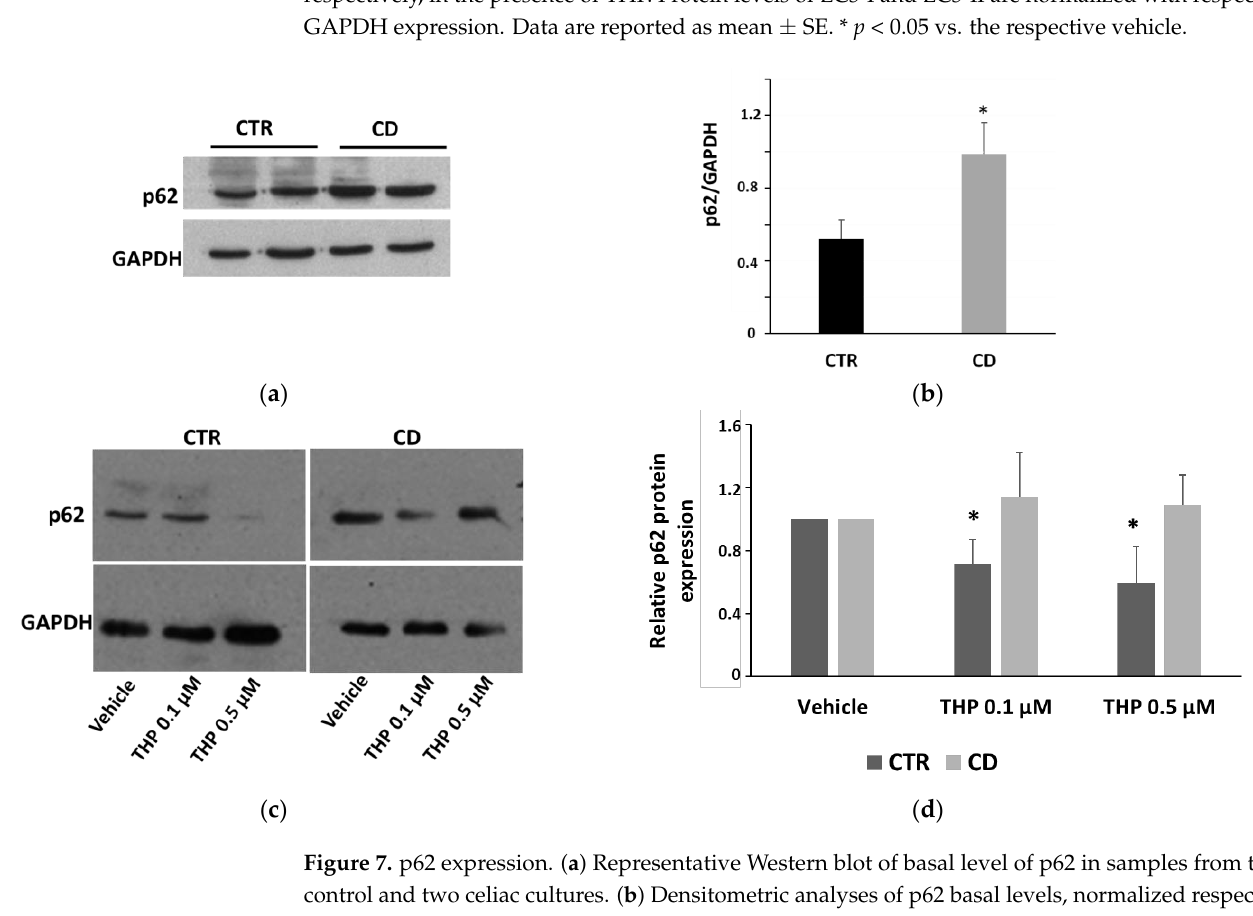
Figure 7. p62 expression. ( a ) Representative Western blot of basal level of p62 in samples from two control and two celiac cultures. ( b ) Densitometric analyses of p62 basal levels, normalized respect to GAPDH expression, relative to samples from four controls and from four celiac cultures. Data are reported as mean ± SE. * p < 0.05 vs. controls (Student’s t- test for unpaired data). ( c ) Representative Western blot anti-p62 on samples from one control and one celiac culture in the presence of THP for 24 h. ( d ) Densitometric analyses relative to Western blot anti-p62 on samples from three control and three celiac cultures in the presence of THP. Protein levels are normalized with respect to GAPDH expression and reported as variations with respect to the relative vehicle-treated sample. Data are reported as mean ± SE. * p < 0.05 vs. the respective vehicle.